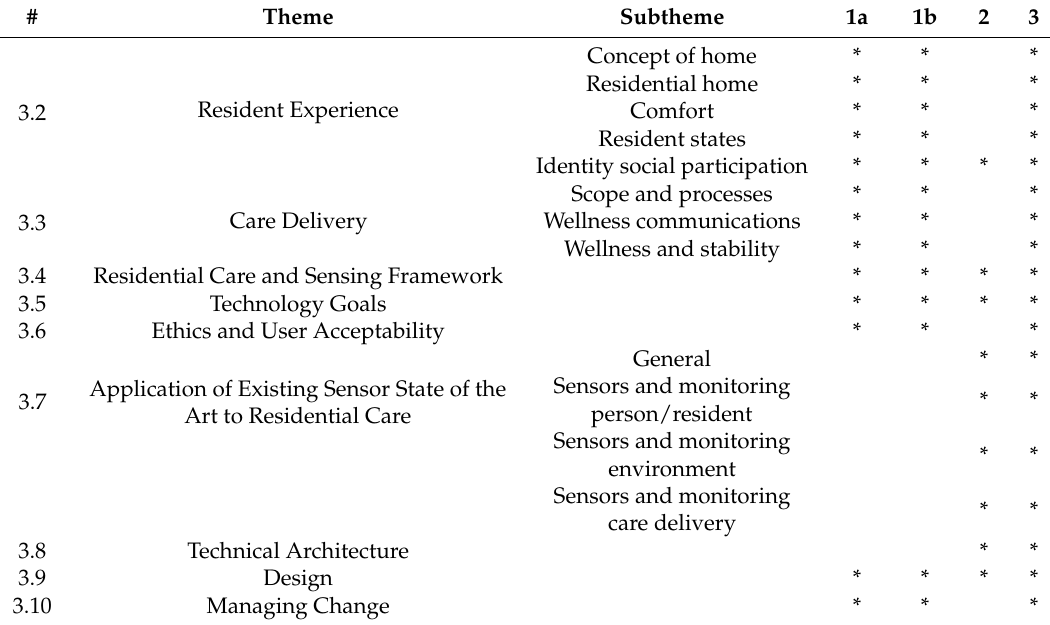
Table 1. Studies and research